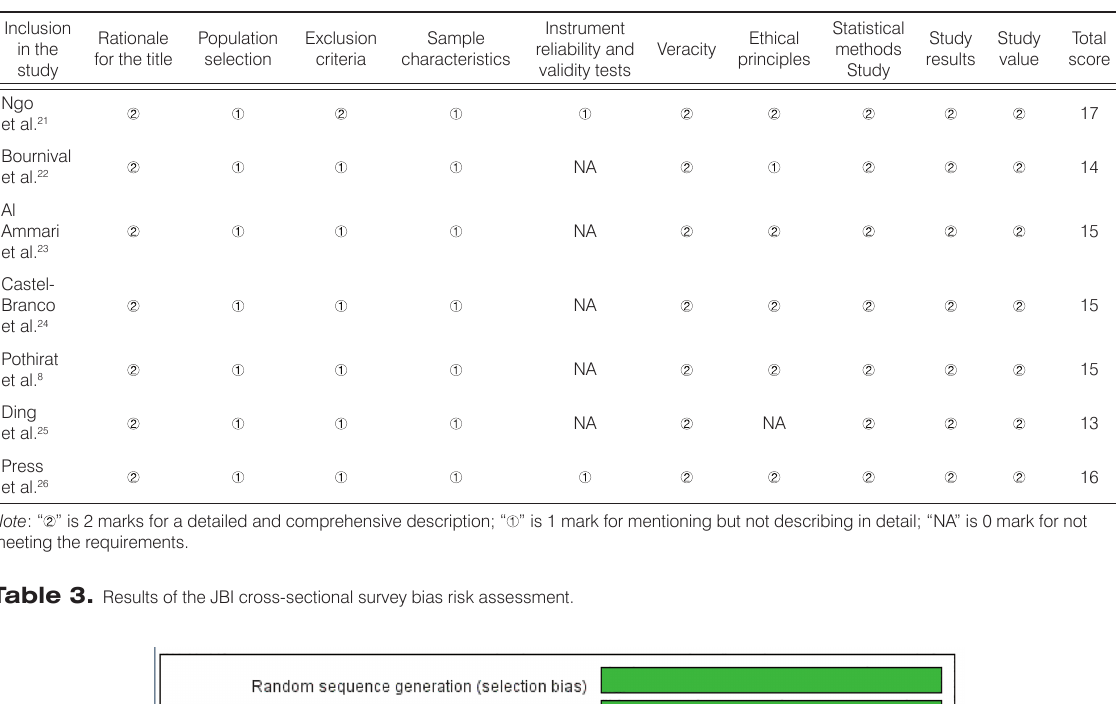
Table 2. Results of risk of bias evaluation of the included literature by NOS score.